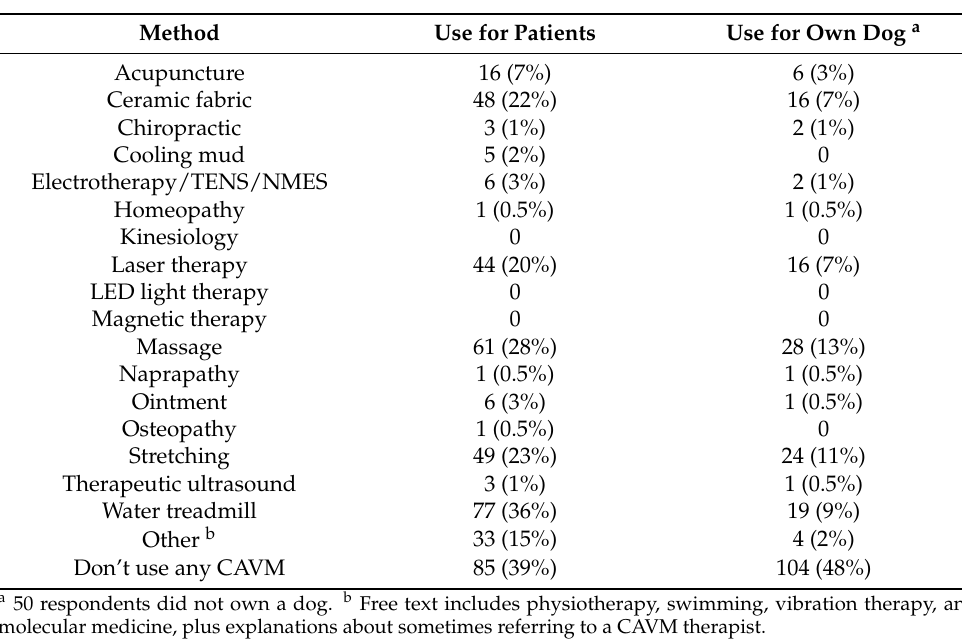
Table 2. Methods used by Swedish small animal veterinarians responding to a questionnaire on complementary and alternative veterinary medicine (CAVM) ( n = 216, multiple choices possible).